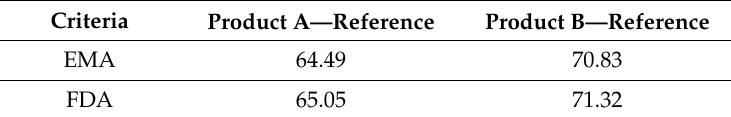
Figure 7. Levy plot and the Inverse Release Functions (IRF).